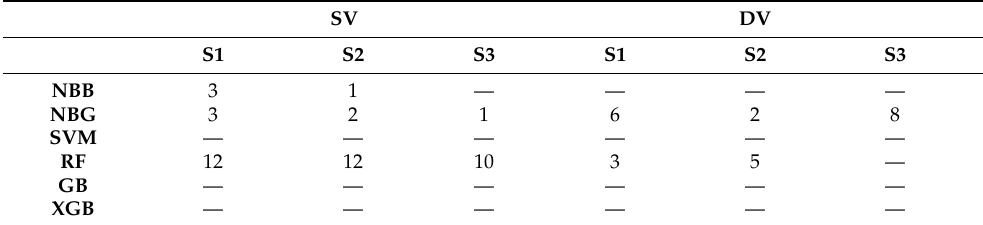
Table 17. Framework algorithm